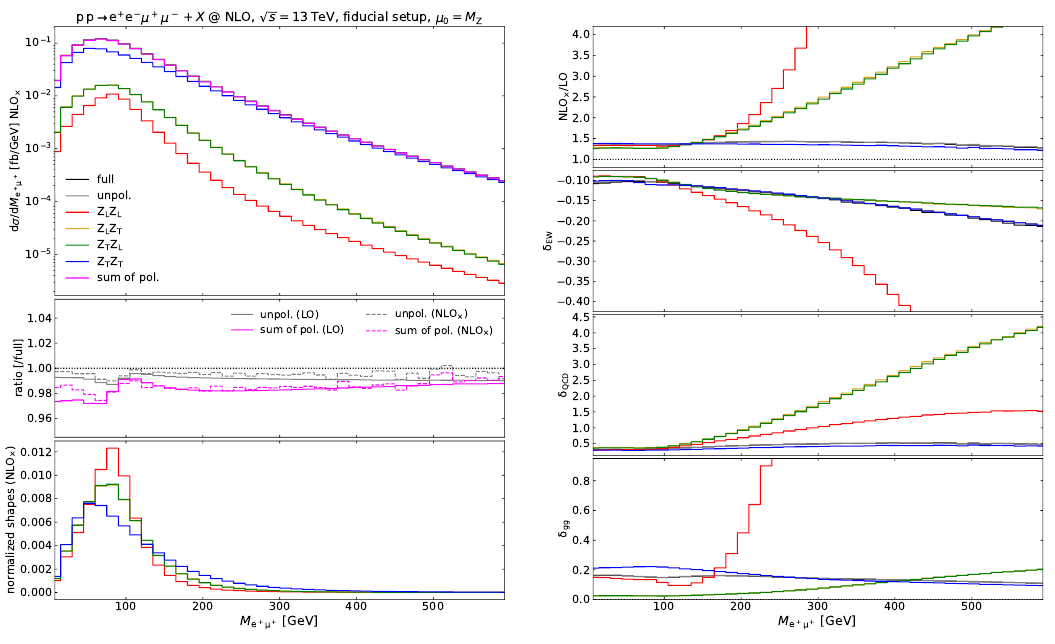
Figure 10 . Distributions in the invariant mass of the e + µ − system. Same structure as in figure 9.